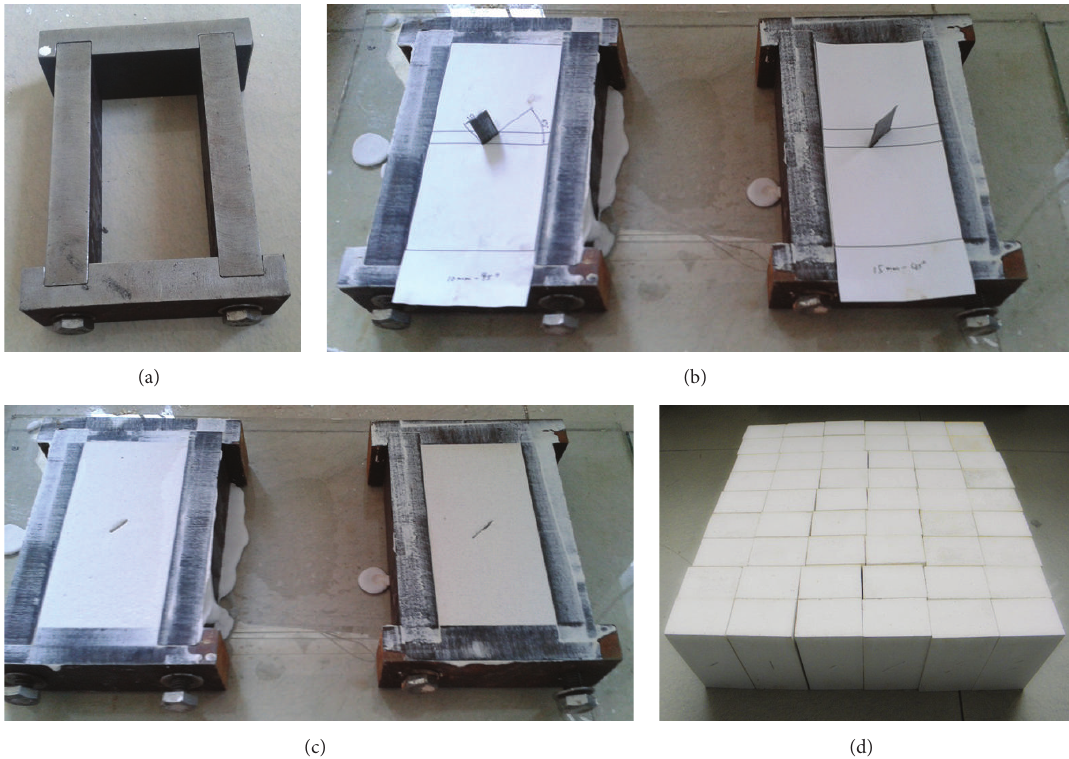
Figure 1: Preparing process of fracture specimens. (a) Mold of the test. (b) Making flaws. (c) Curing the specimens. (d) Standard specimens.